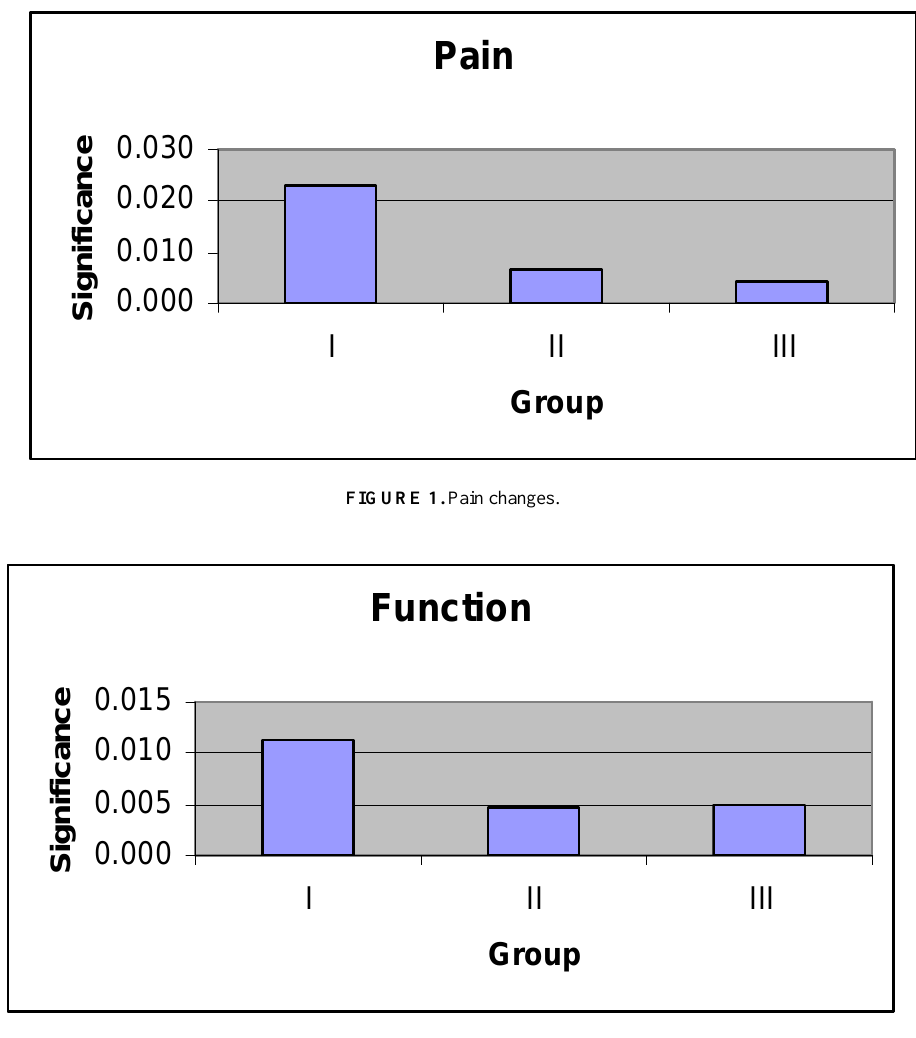
FIGURE 2. Function